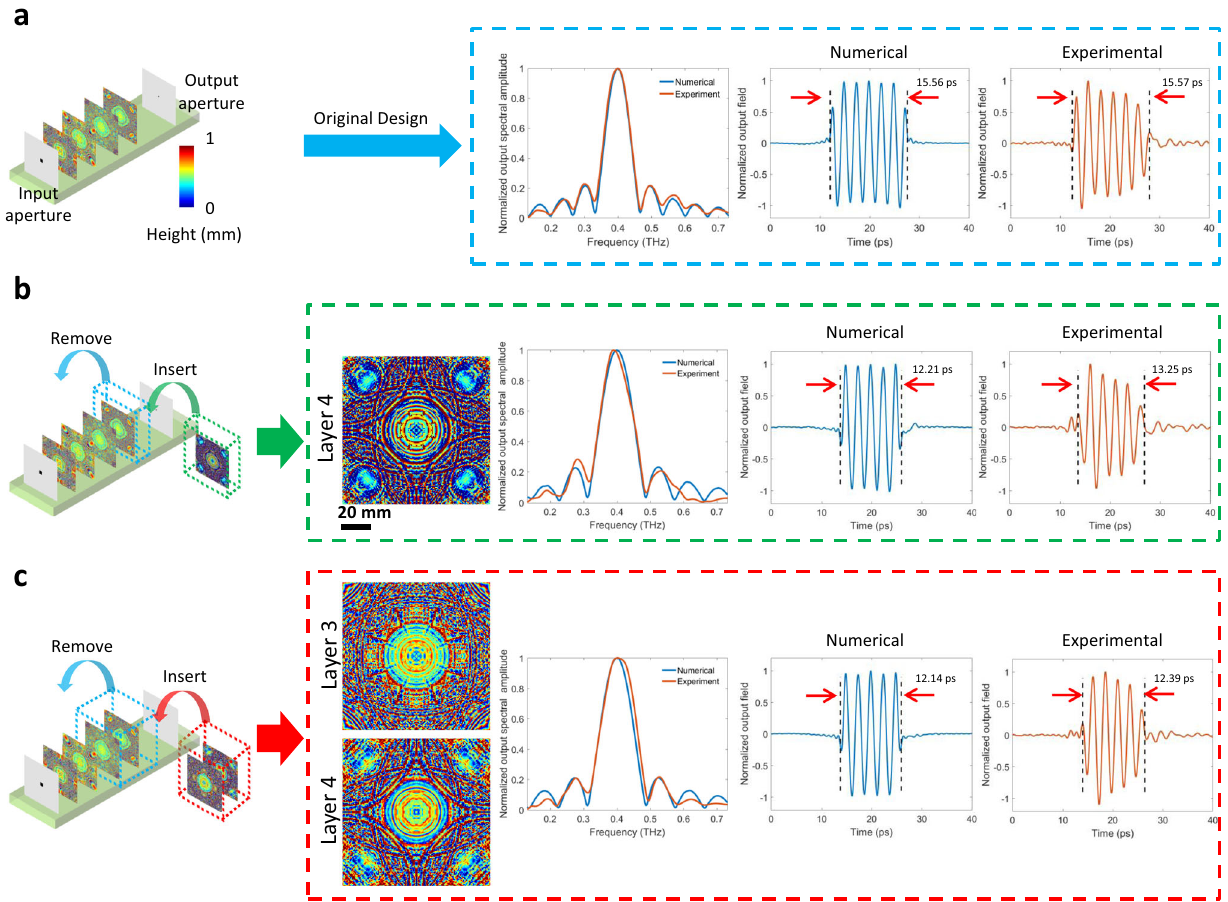
Fig. 5 Changing the output temporal waveform of a diffractive network by a physical transfer learning approach. a The temporal and spectral output distributions (blue dashed box), synthesized by the original diffractive design that was trained to generate a 15.50 ps square pulse. b Replacing the last diffractive layer with another, newly trained diffractive layer to synthesize a 12.03 ps square pulse at the output. The thickness pro fi le of the newly trained diffractive layer is shown, together with the normalized spectral and temporal pro fi les synthesized by this new diffractive network in green dashed box. c Replacing the last two diffractive layers with newly trained, two diffractive layers to synthesize a 12.03 ps square pulse at the output. The thickness pro fi les of the newly trained diffractive layers are shown, together with the normalized spectral and temporal pro fi les synthesized by this new diffractive network in red dashed